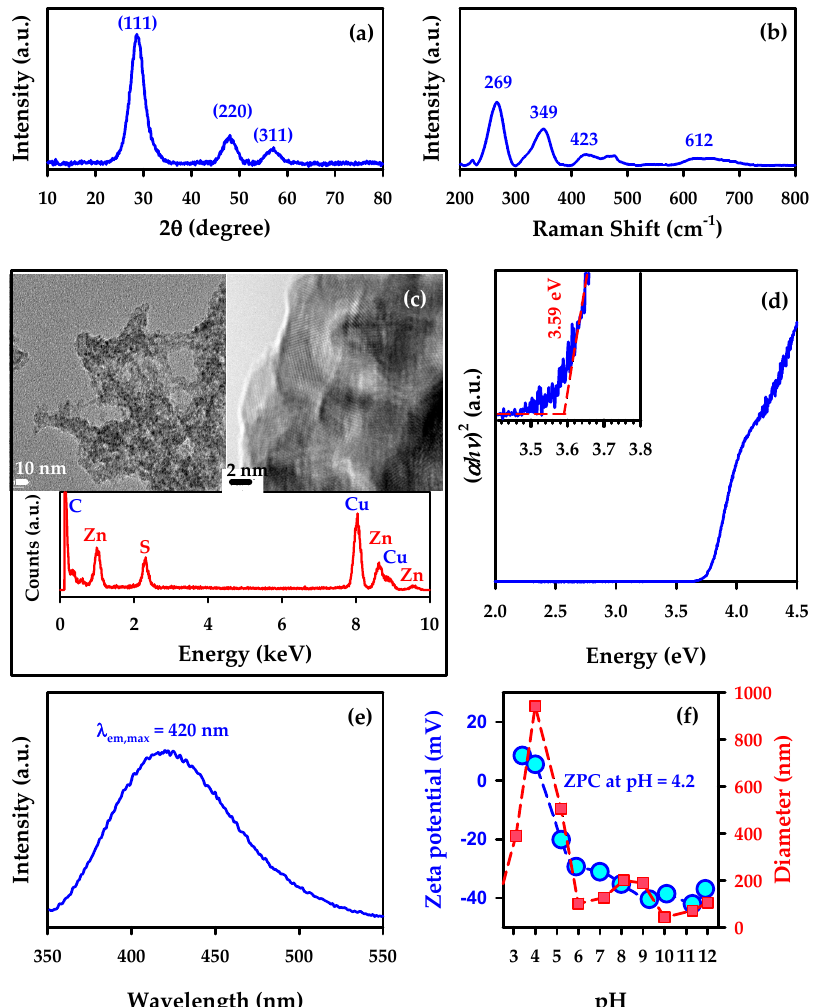
Figure 2. Example for the characterization of a ZnS model semiconductor. Further experimental details about the synthesis of ZnS, data collection, and interpretation can be found in references [2,9]. ( a ) Powder X-ray diffractogram (XRD) for cubic ZnS. ( b ) Raman spectrum for cubic ZnS. ( c ) Transmission electron microscopy (TEM) of ZnS with energy-dispersive X-ray spectroscopy (EDS), showing that the 1:1 stoichiometric ratio of Zn:S is maintained on the surface. ( d ) Tauc plot obtained by plotting the square of the product of the absorption coefficient (proportional to the Kubelka–Munk function recorded by DRUVS) and energy in eV vs energy. A linear extrapolation provides the bandgap of 3.59 eV (or λ = 345 nm) for colloidal ZnS suspended in water. ( e ) Photoluminescence spectrum of colloidal ZnS suspended in water and excited at λ = 300 nm with an emission maximum at λ em,max = 420 nm. ( f ) Dynamic light scattering (DLS) analysis of colloidal ZnS suspended in water showing the (blue circle) zeta-potential and (red square) particle size (diameter from the unimodal distribution) at variable pH with a zero point of charge (ZPC) at pH = 4.2.